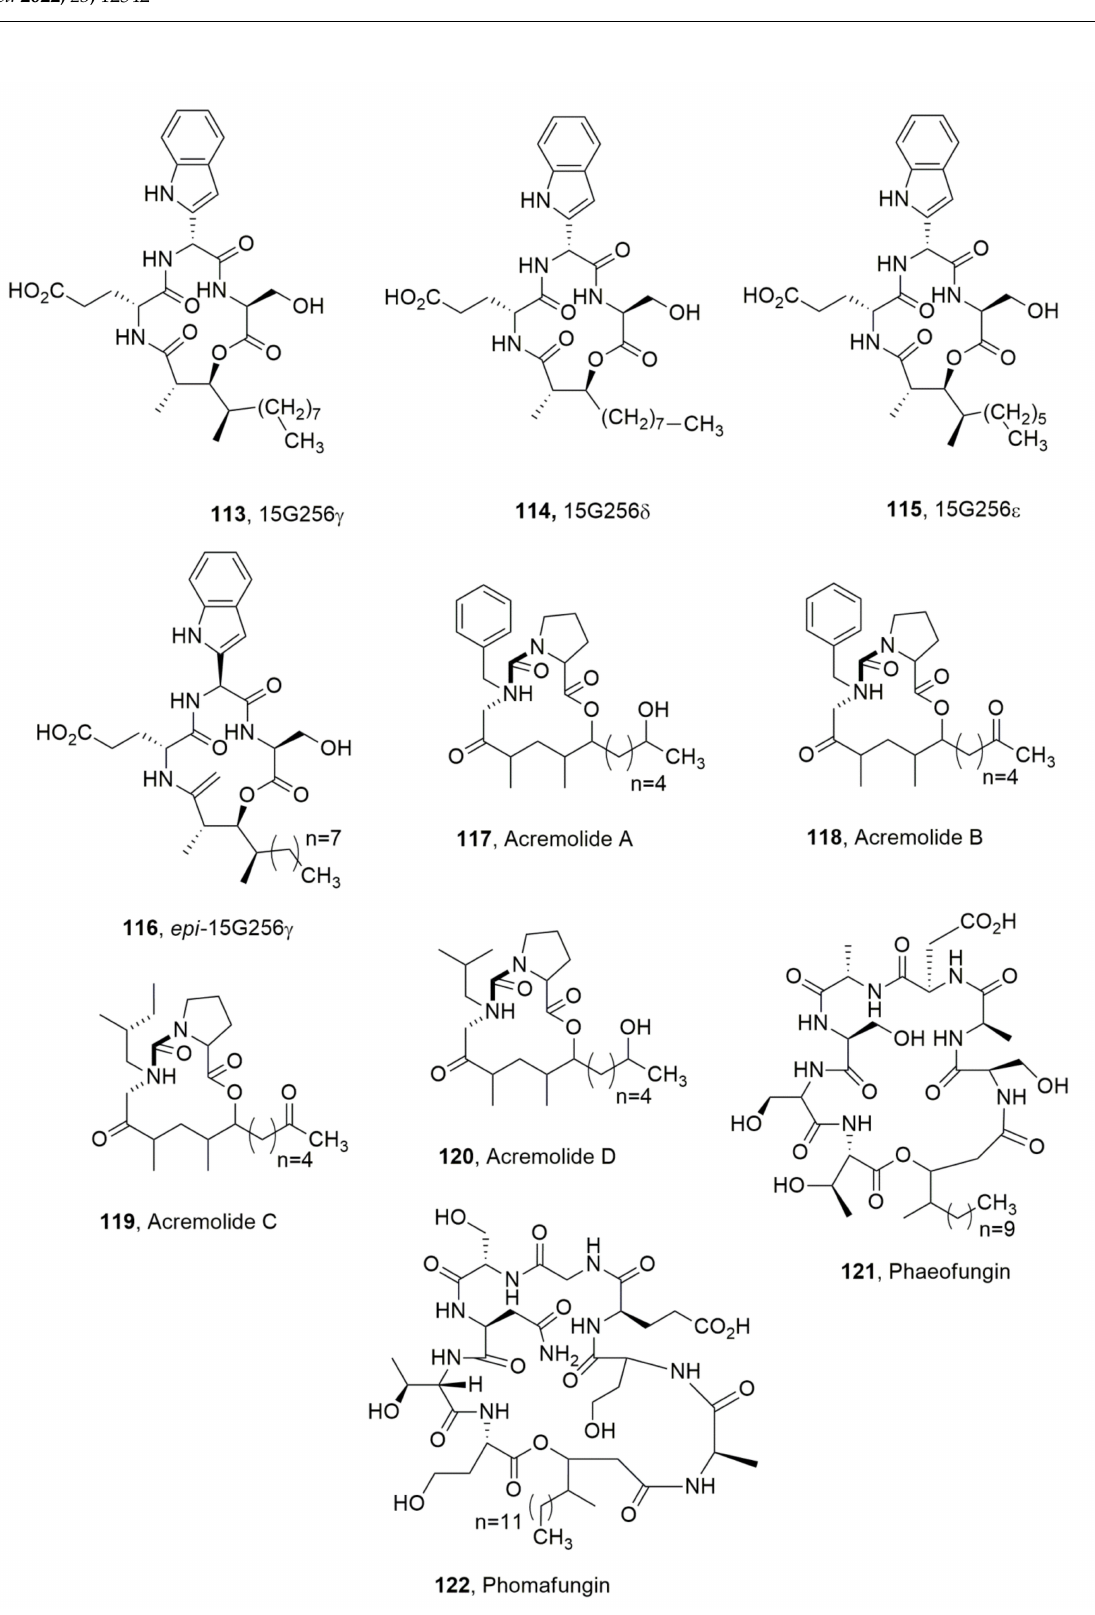
Figure 13. Lipodepsipeptides produced by Hypxylon oceanicum ( 113 – 115 ), Acremonium sp. ( 117 – 120 ), Phaeoshaeria sp. ( 121 ) and Phoma sp. ( 122